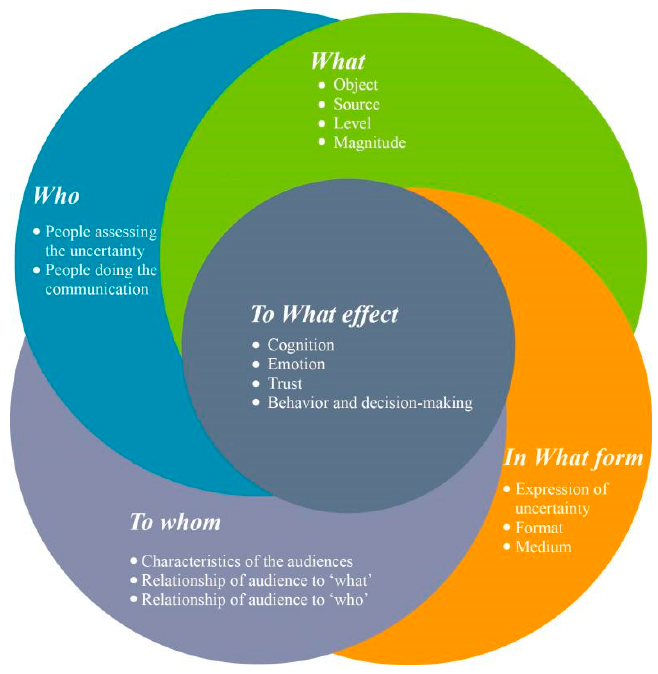
Figure 1. Aspects of communication and